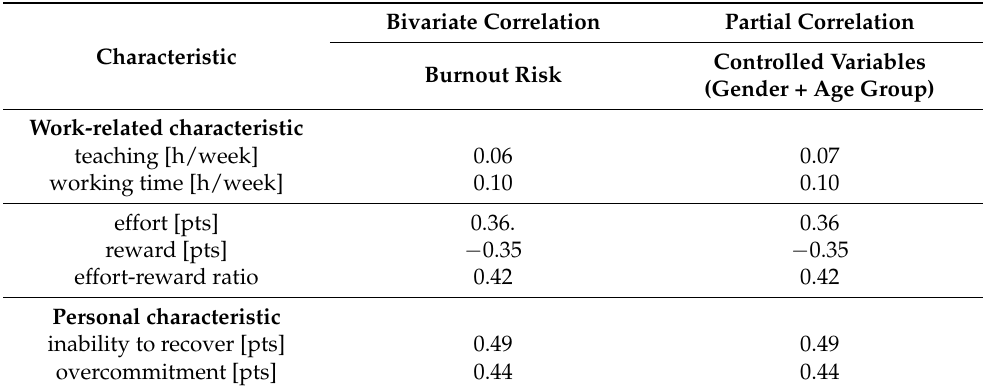
Table 6. Bivariate and partial correlations between work-related and personal characteristics and the burnout risk of teachers ( n =